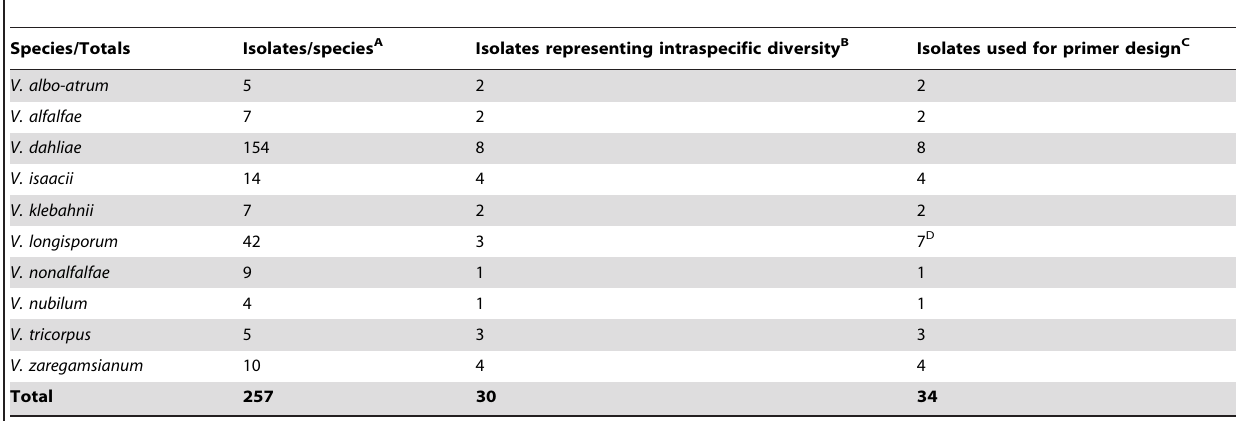
Table 1. Numbers of isolates used for primer design in relation to numbers of isolates and genetic diversity of each Verticillium species in Inderbitzin et al. [4,47].